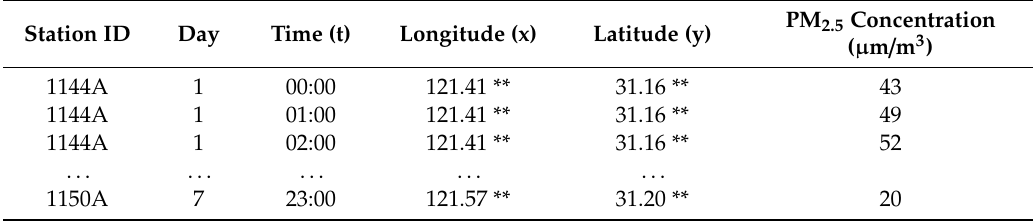
Table 2. Instance of ground-station PM 2.5 Concentration Data.